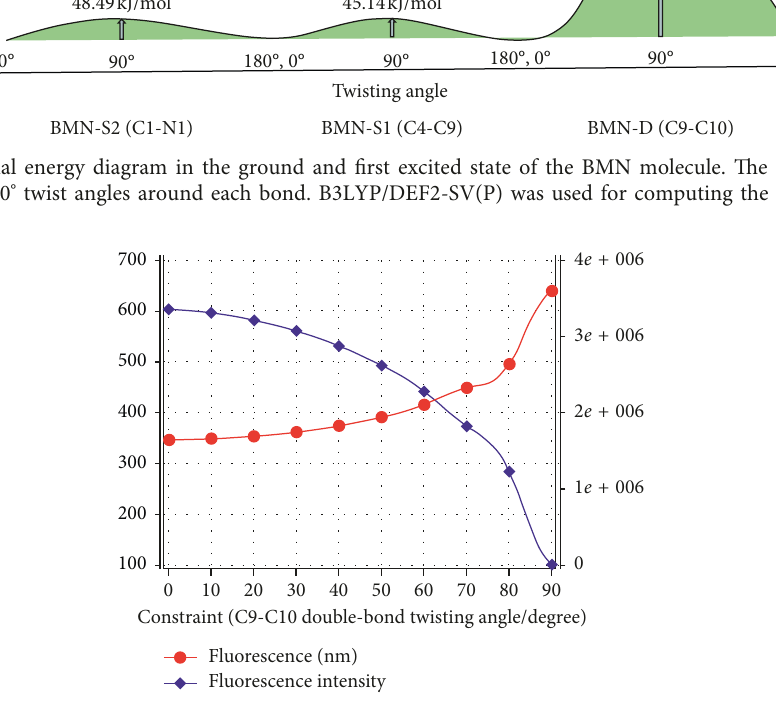
Figure 6: Twist-induced fluorescence wavelength (red) and intensity (blue) changes. The molecule does not fluoresce at 90 ° twist. Progressive increase in the twist angle results in fluorescence red shift with quenched emission. Calculated using the CIS/6-31G ∗ method of Spartan’16 parallel suite. Plotted using Spartan’16 GUI.